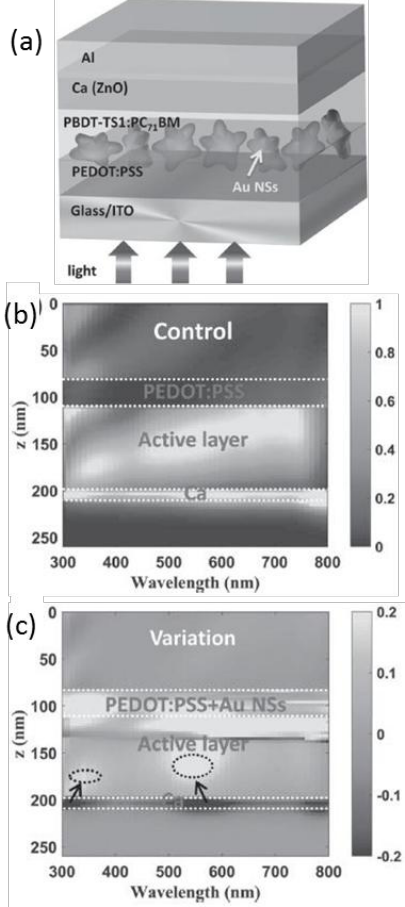
Figure 5. ( a ) The schematic illustration of the structure of Au nanostars (NSs) incorporated OSC; ( b ) the absorptive power distributions of the control OSC (without Au NSs). The absorptive power in Ca cannot contribute to the carrier generation and would be wasted; ( c ) the variation of absorptive power distribution due to the incorporation of Au NSs compared to the control OSC [53]. Reprinted with permission from Ref. [53].